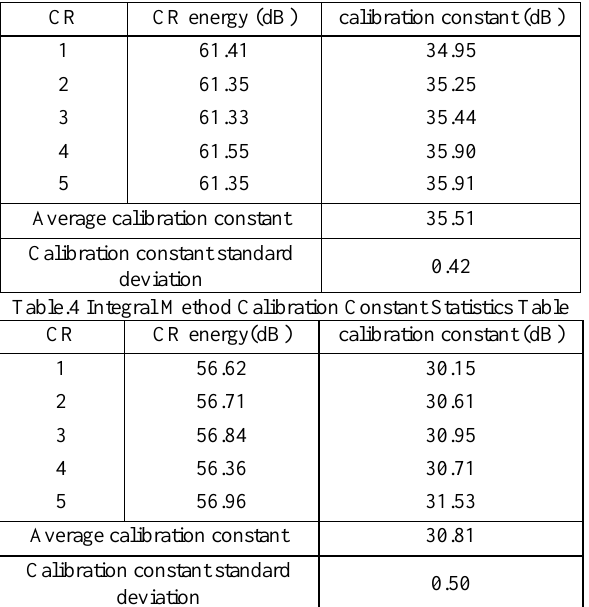
Table.5 Peak Method Calibration Constant Statistics Table